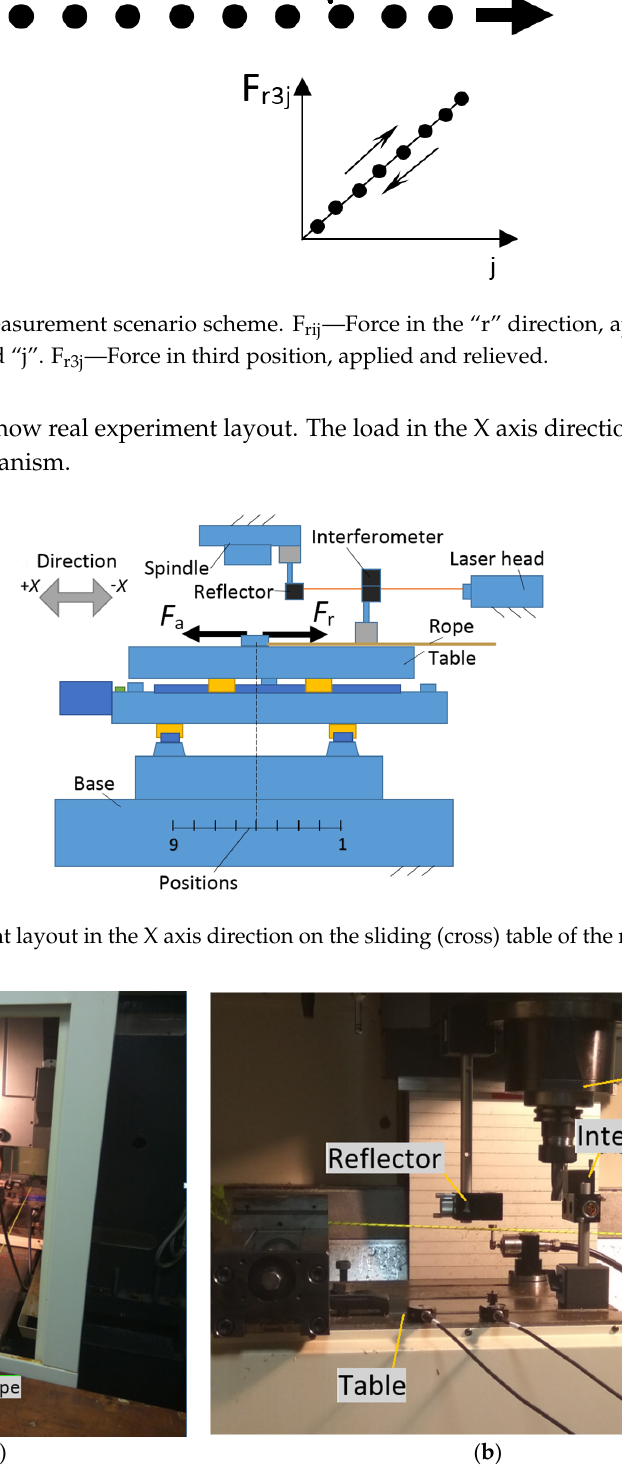
Figure 4. ( a ) Application of the load to the table through a rope mechanism—axis X; ( b ) Reflector and interferometer arrangement in the workspace of the milling machine.